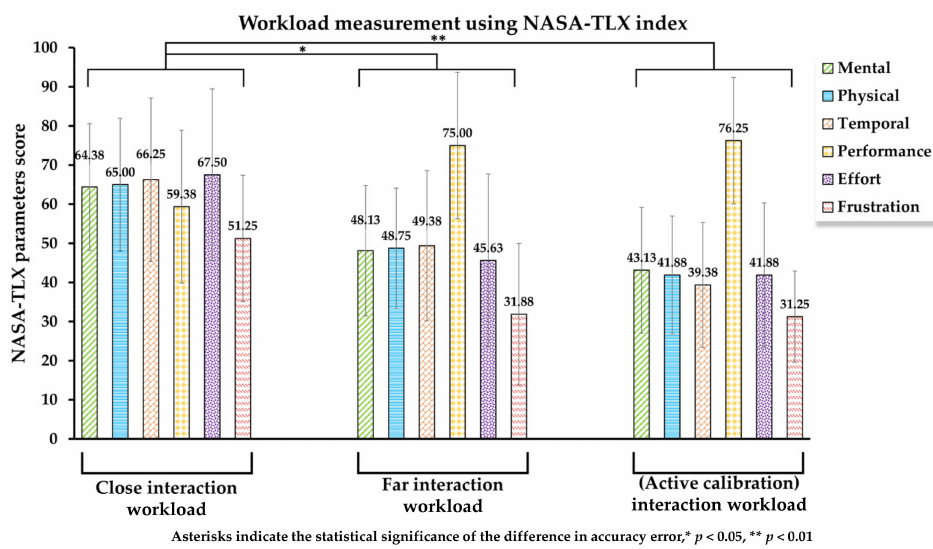
Figure 14. Workload measurement for the three interaction